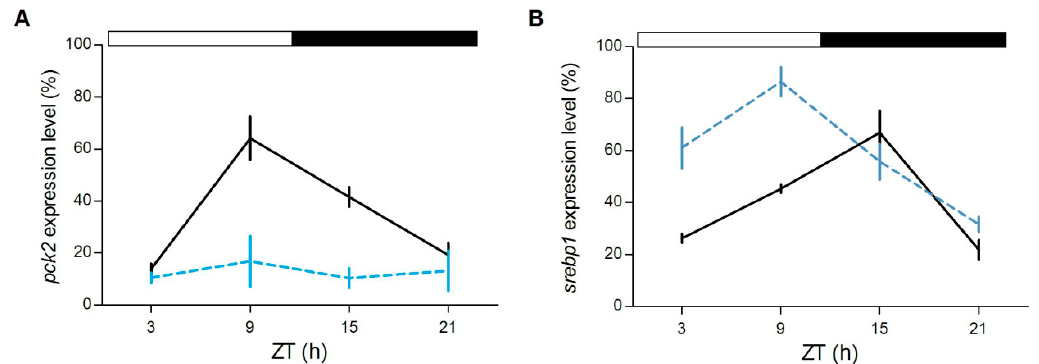
Figure 9. Daily expression levels of genes involved in metabolism in zebrafish adult liver. qPCR analysis of pck2 ( A ) and srebp1 ( B ) in the liver of zebrafish exposed to LD cycles. For both panels, each point represents the mean ± SEM (n = 4). gr +/+ = solid line; gr − / − = dotted line. For more details see Figure 4.